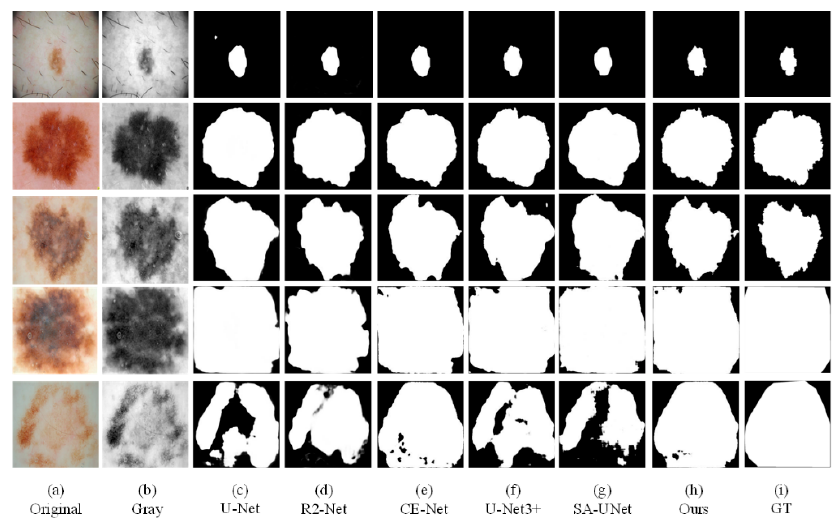
Figure 10. The visual segmentation comparison chart of each comparison network on ISBI2016. ( a , b ) represent original and gray-scale images of input, ( i ) represents GT maps. ( c – g ) represent the segmentation results of comparison networks, respectively. ( h ) represents the segmentation result of our proposed method, from which it can be seen that the segmentation result of our proposed method is the closest to the GT maps.